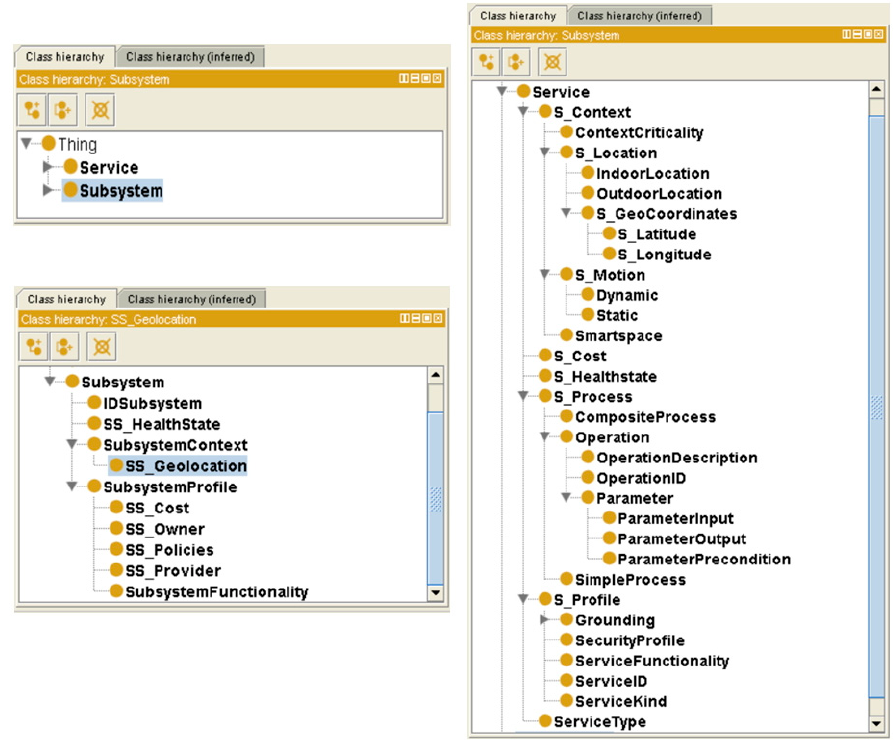
Figure 4. The visualized overall structure of nSSOO.